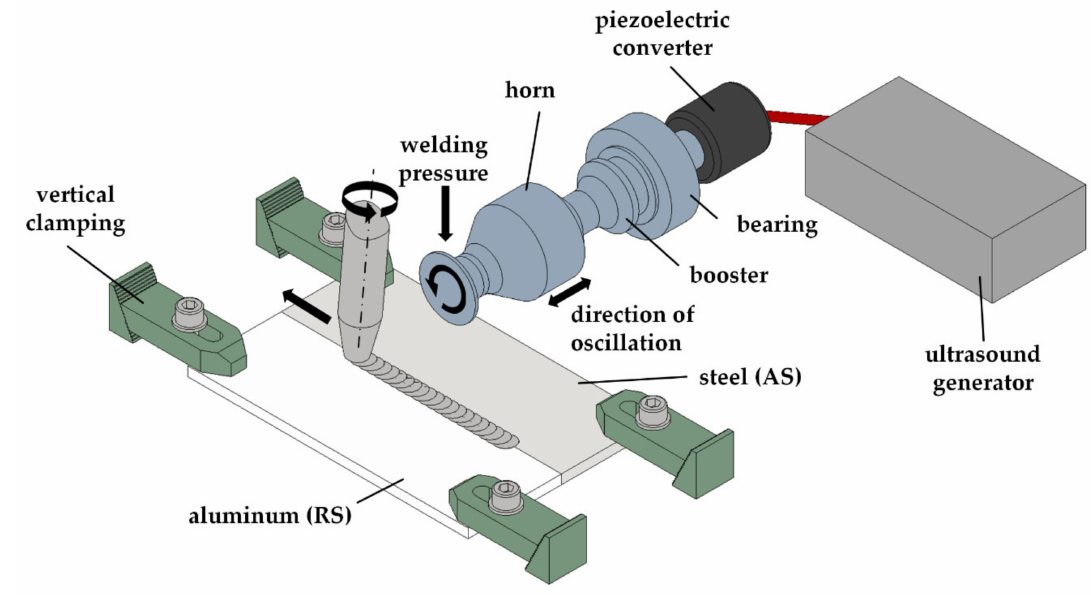
Figure 1. General setup of the ultrasound enhanced friction stir welding with exemplary clamping claws for the vertical